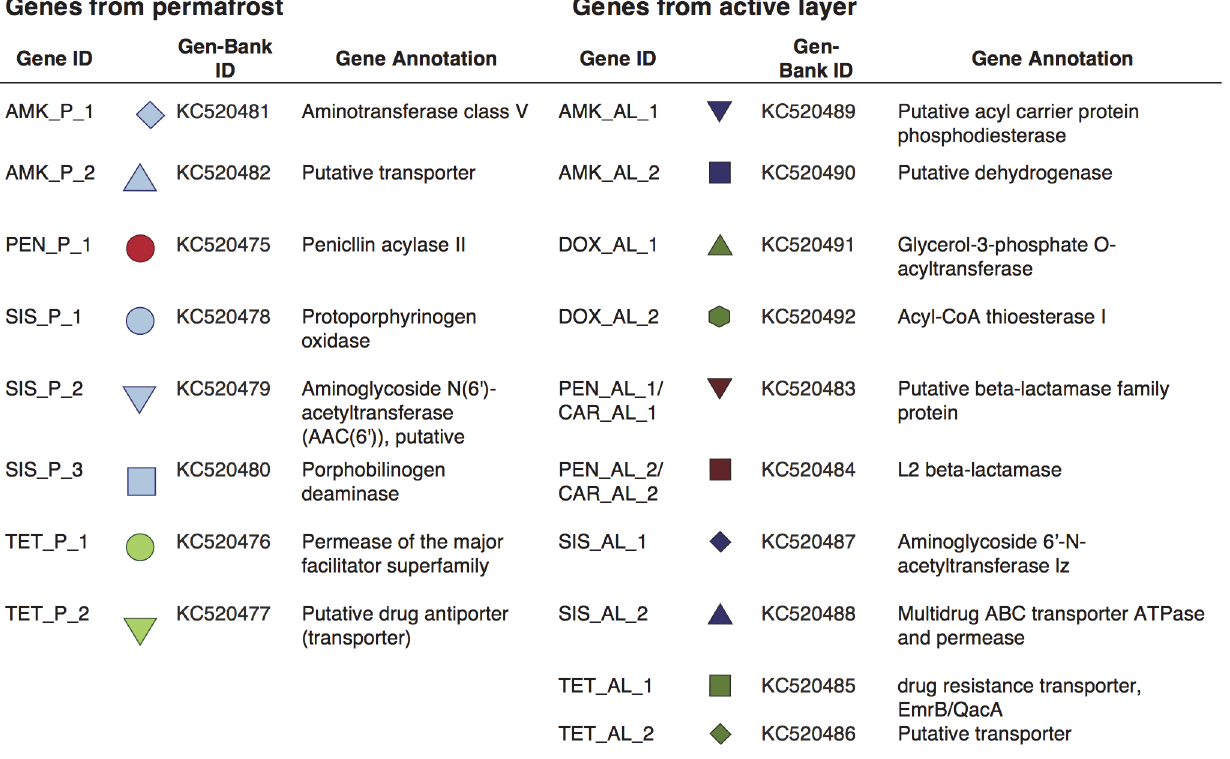
Fig 2. List of resistance genes and their predicted